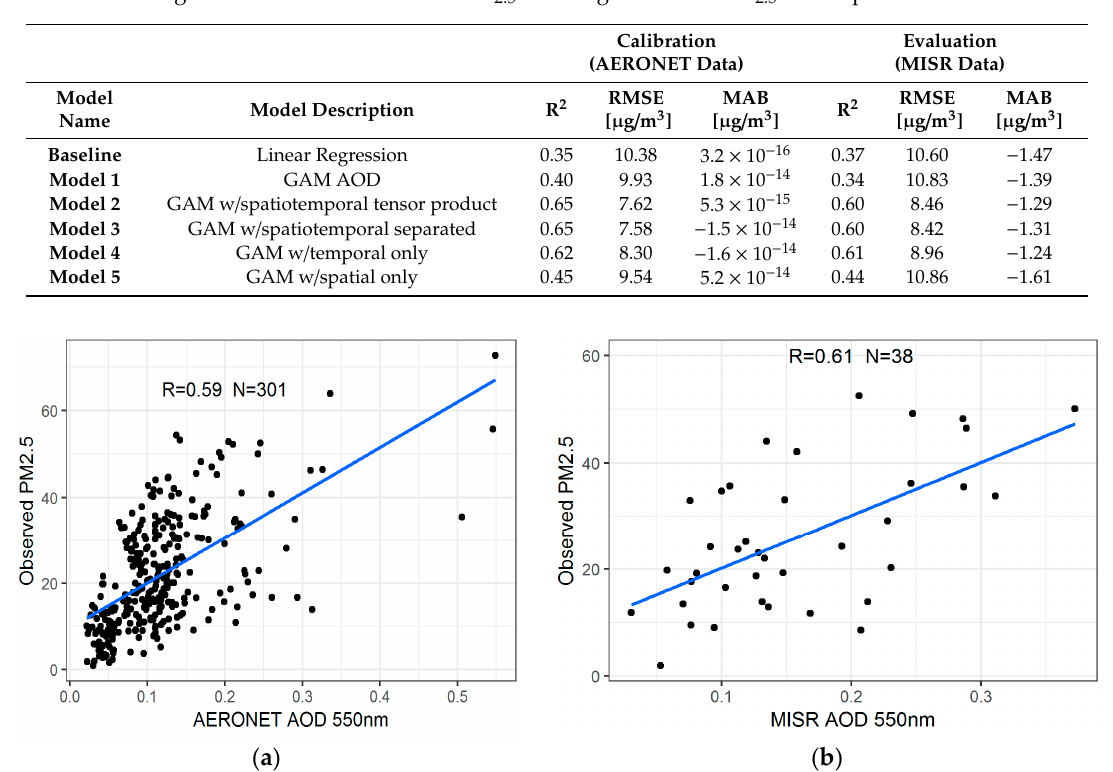
Table 2. Stage 1 DRAGON AERONET—PM 2.5 and Stage 2 MISR—PM 2.5 model performance results.